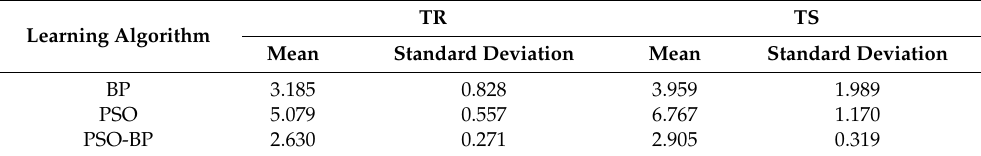
Table 6. Mean and standard deviation of the RMSE for the developed